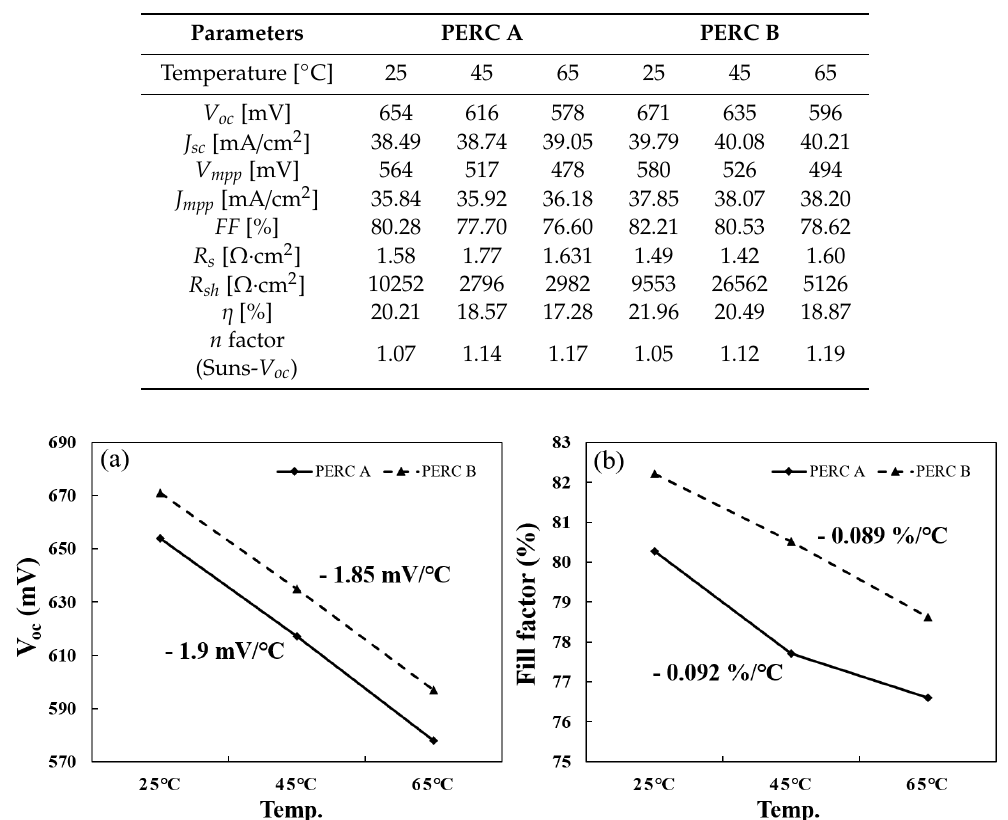
Table 1. Results of illuminated J - V measurement and n factor (from Suns- V oc ) of PERC A and B according to temperature dependence.